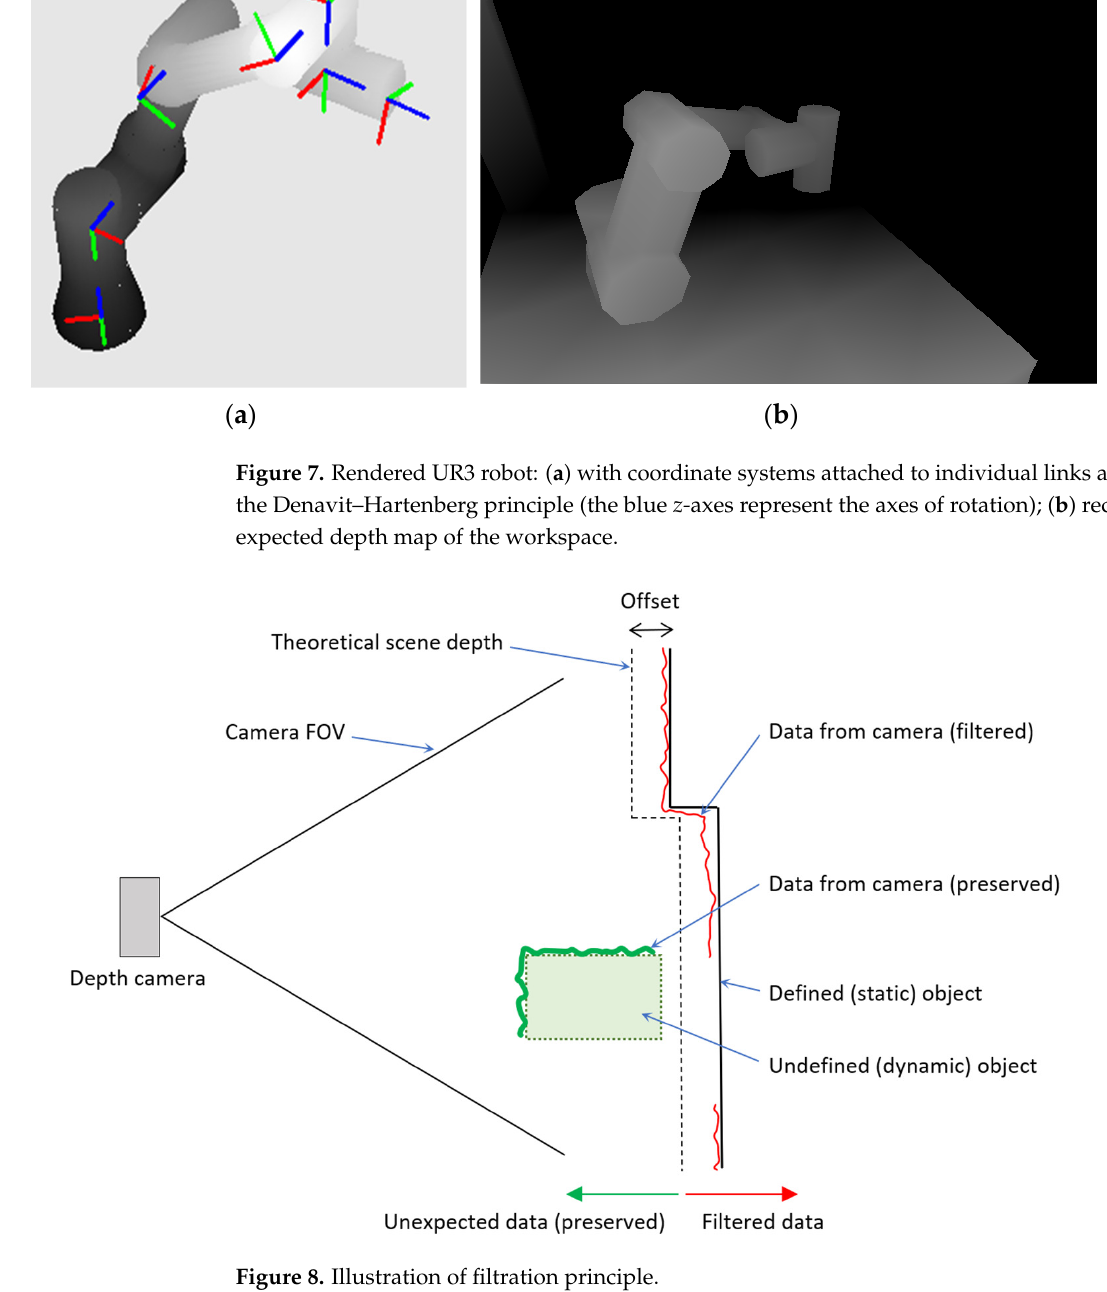
Figure 7. Rendered UR3 robot: ( a ) with coordinate systems attached to individual links according to the Denavit–Hartenberg principle (the blue z- axes represent the axes of rotation); ( b ) recon- structed expected depth map of the workspace.